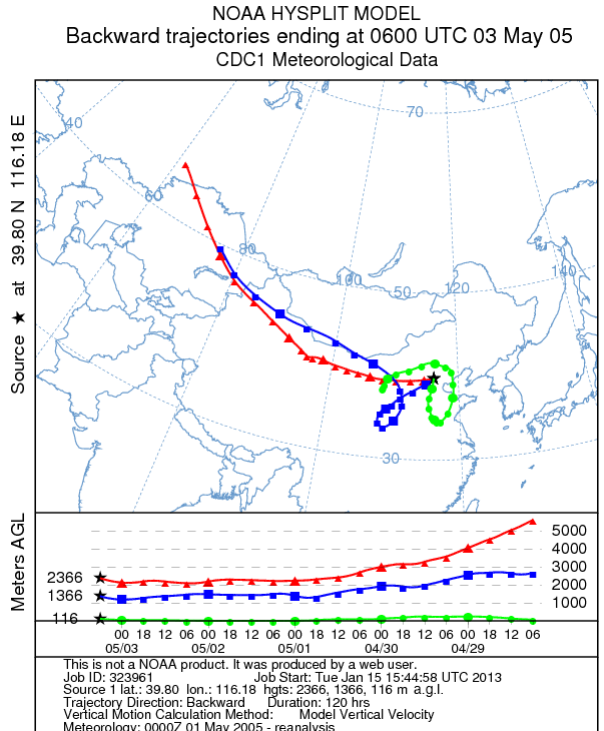
Figure 10. Five-day back trajectories arriving at the altitudes of 150m (green line), 1400m (blue line), and 2400m (red line) over Beijing at 14:00 local time on 3 May 2005. AGL and hgts denote the altitudes above ground level. The ozonesonde station is 34ma.s.l. Note that 1366ma.g.l. corresponds to 1400ma.s.l. and so